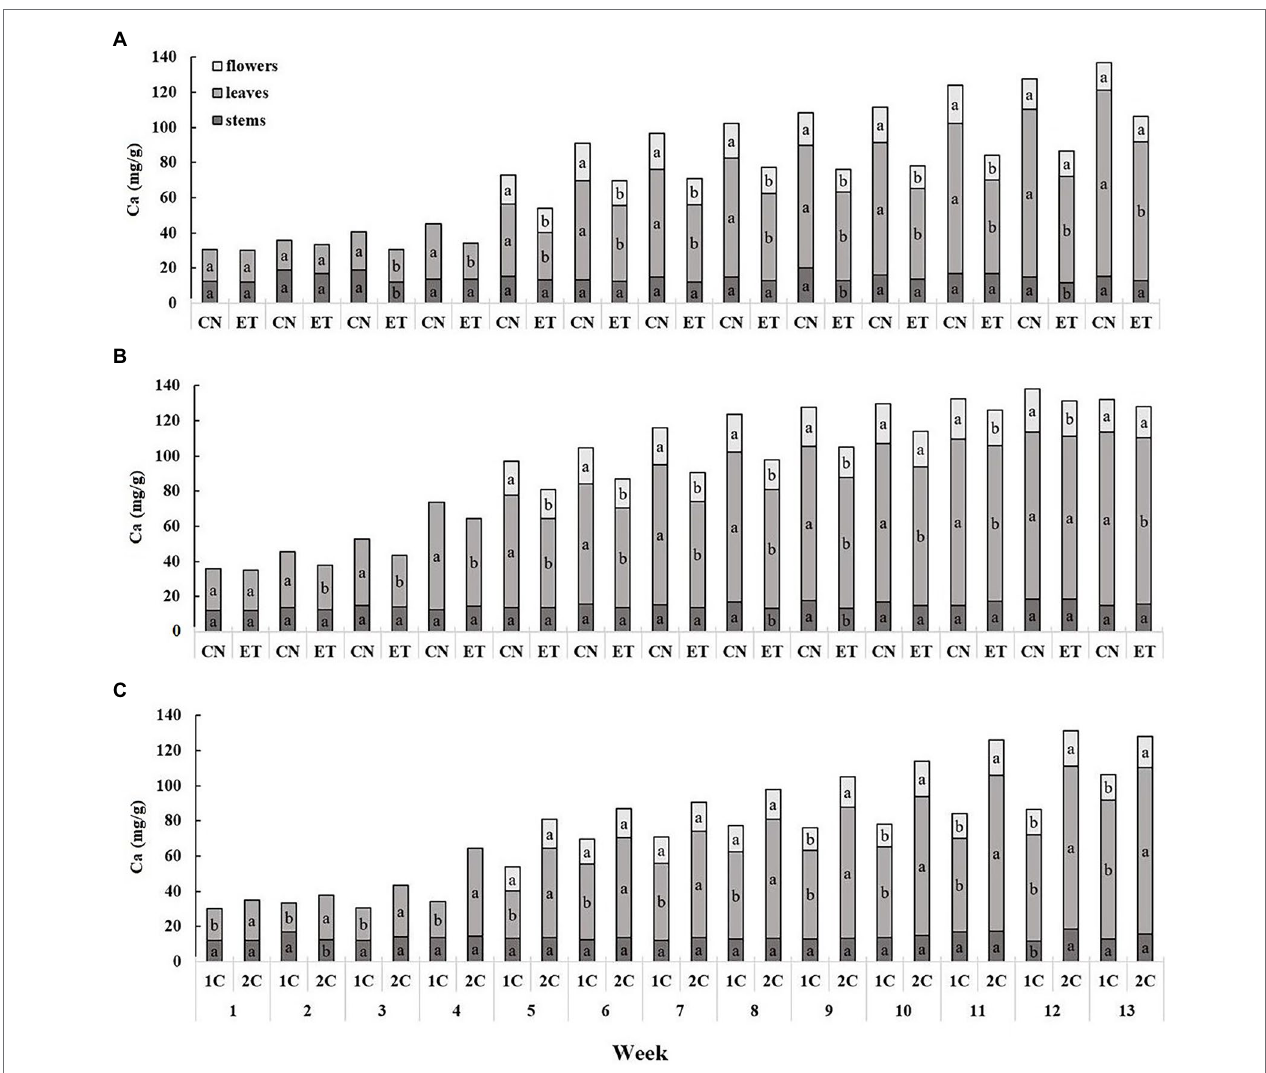
FIGURE 3 | Distribution of calcium among the organs of medical cannabis plants as affected by amino acid (AA) supplementation and nutrient cycle. Ca concentration in control (CN) and enhanced treatment (ET) plants with AAs nutritional supplement in recirculation (1C) growing cycle (A) , in drain-to-waste (2C) growing cycle (B) , ETs in 1C and 2C (C) in stems, leaves, and flowers. Data are means ± SE ( n = 3). The different small letters inside the bars represent significant differences within the plant organs (stems, leaves, and flowers) between the variants in a particular week according to Tukey’s HSD test at α =